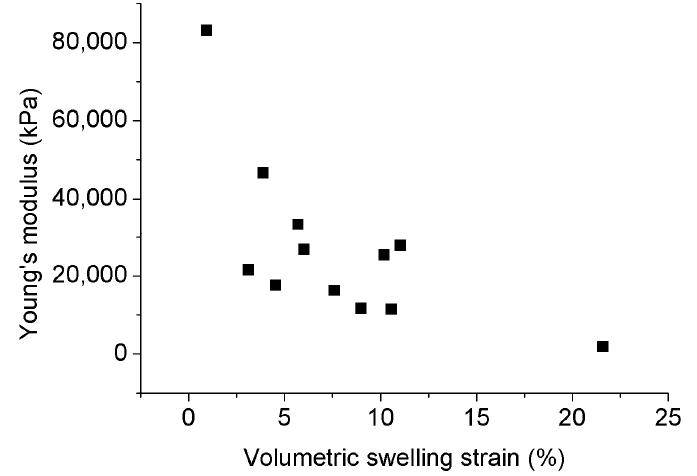
Figure 9. Relationship between Young’s modulus and volumetric swelling strain [78].